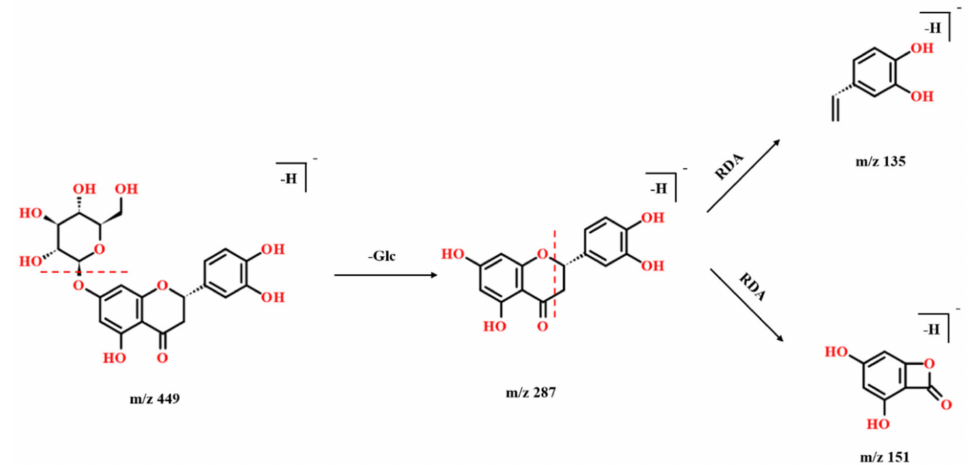
Figure 4. The possible fragmentation pathways of miscanthoside (compound 51) in the negative ion